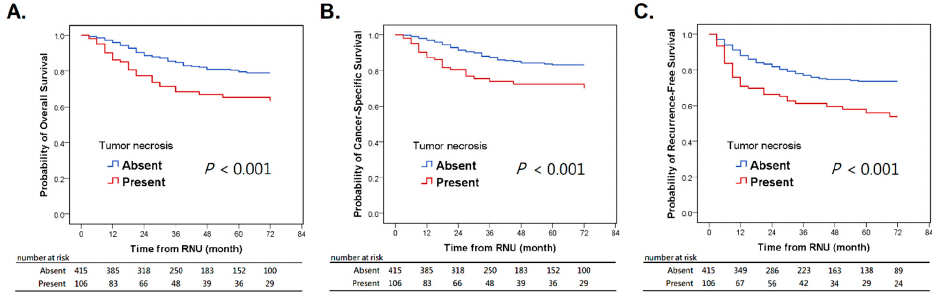
Figure 1. Kaplan–Meier survival curves for overall survival ( A ), cancer-specific survival ( B ), and recurrence-free survival ( C ) in UTUC patients according to tumor necrosis. UTUC: upper tract urothelial carcinoma.